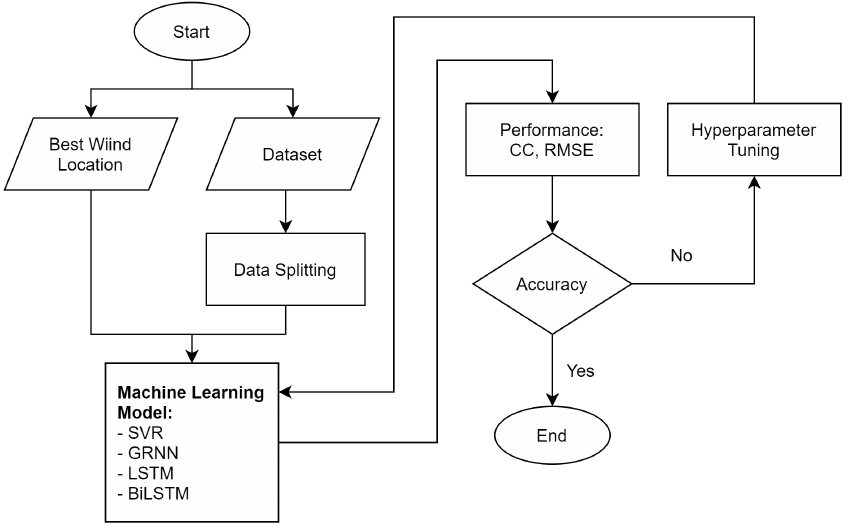
Figure 13. Flowchart for machine learning